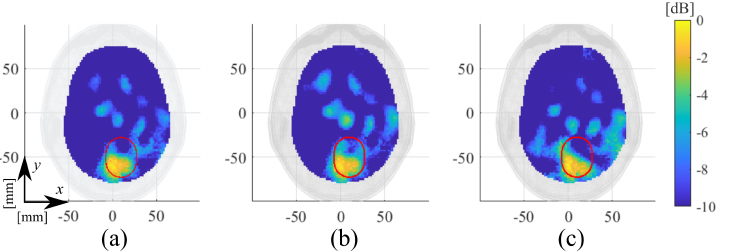
Figure 16. Amplitude values of the reconstructed dielectric contrast for re-test experiment; transverse views cut in their maximum, normalized to the maximum value of ICH-MTP_1: ( a ) baseline, ( b ), re- test 1, and ( c ) re-test